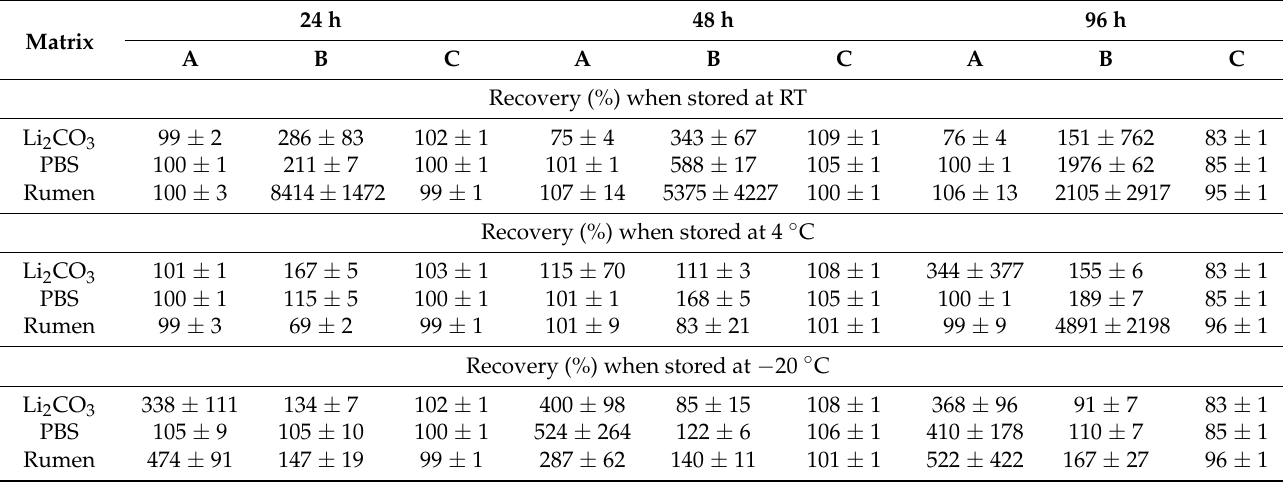
± standard deviation.